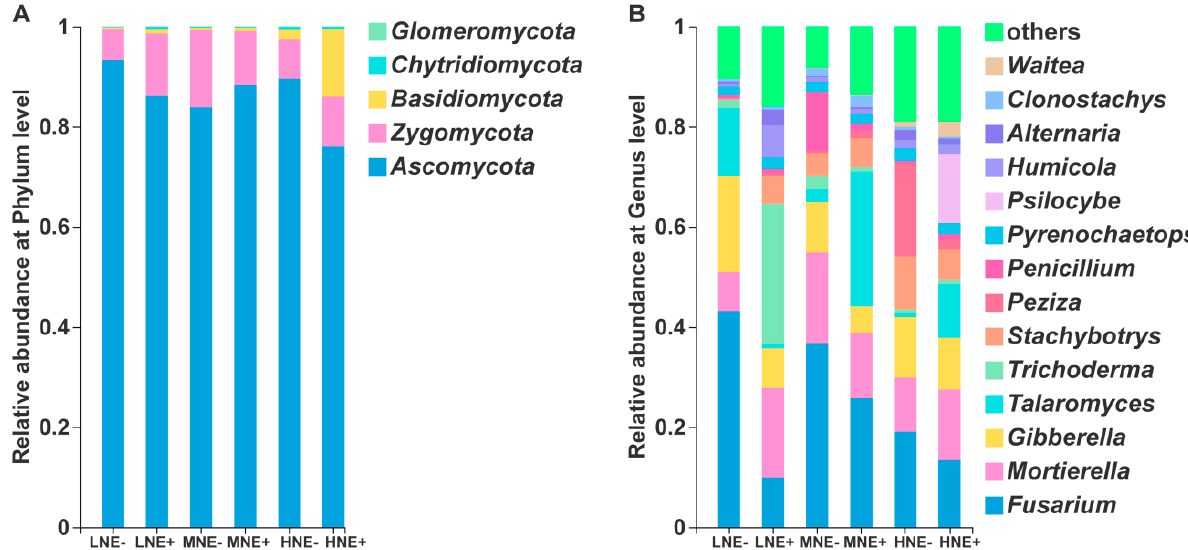
Figure 7. The composition of the fungal microbiome in the rhizosphere at the phylum level ( A ) and genus level ( B ). LNE − : low nitrogen without inoculation; LNE+: low nitrogen with inoculation; MNE − : moderate nitrogen without inoculation; MNE+: moderate nitrogen with inoculation; HNE − : high nitrogen without inoculation; HNE+: high nitrogen with inoculation. The results were obtained based on ITS sequencing. The statistical comparison of the relative abundance of fungi in the rhizosphere at the genus level is shown in Figure S5.